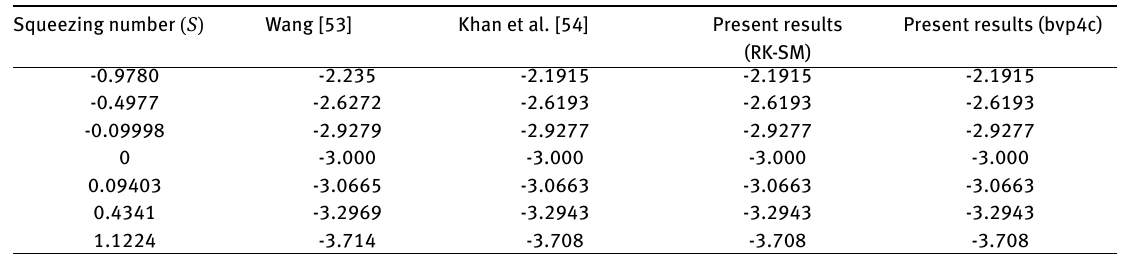
Table 1a: Comparison of present similarity solutions with Wang [53] and Khan et al. [54] results for F (cid:48)(cid:48) (1) for different values of S when Ha = N b = N t = Ω T = Ω C = 0